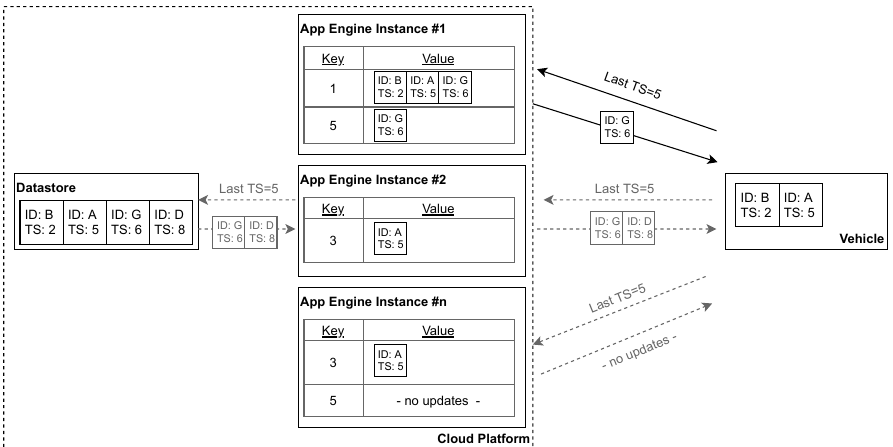
Figure 7. Sharding during instruction distribution. Datastore acts as single source of truth. App Engine instances cache queries locally. The timestamp submitted by the car acts as cache key and query parameter. The cache items can be out of sync as long as they represent an ordered subsequence and eventually expire (See Section